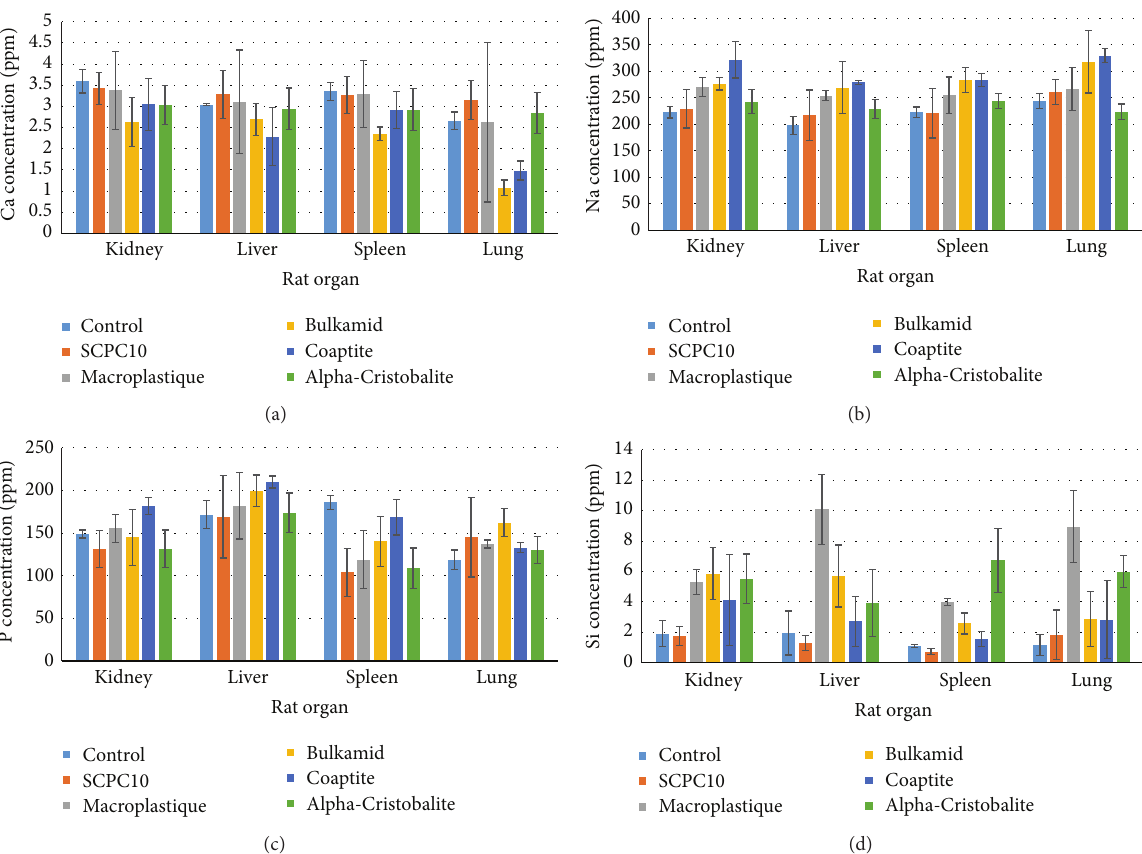
Figure 7: Bar graphs summarizing the ion levels of particle components in the distant